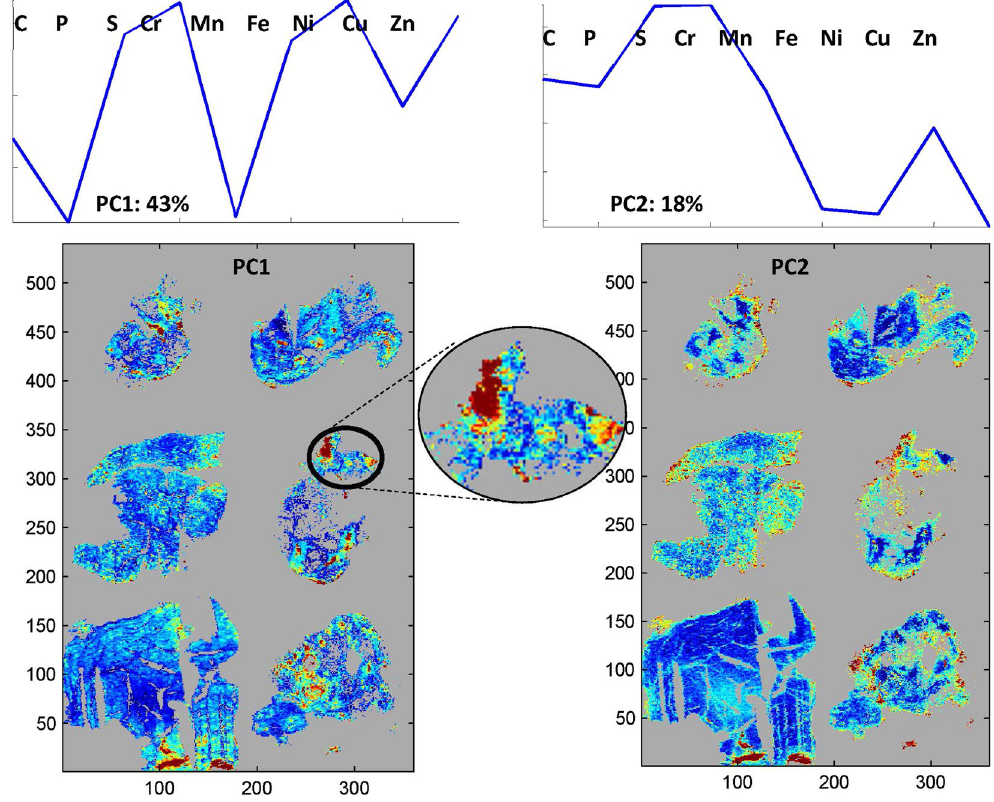
Figure 7. Top: shape of the first 2 principal components PC1 and PC2. Bottom score maps for PC1 and PC2 of 6 tissue sections. PCA was computed only on the spectra with 13 C values above 0 as shown in Fig. 5.